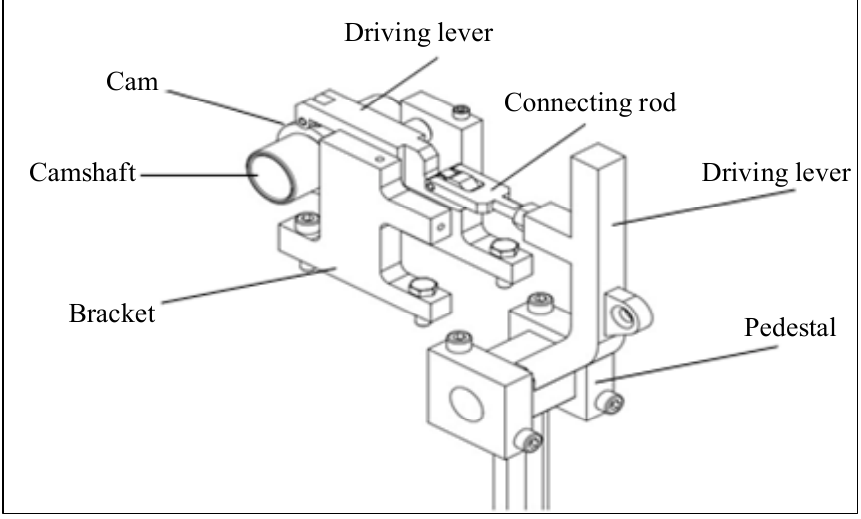
Figure 5. Schematic diagram of locking device of opening and closing net mechanism.